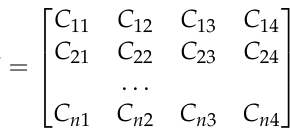
Figure 10. Connection relationship of four configurations.